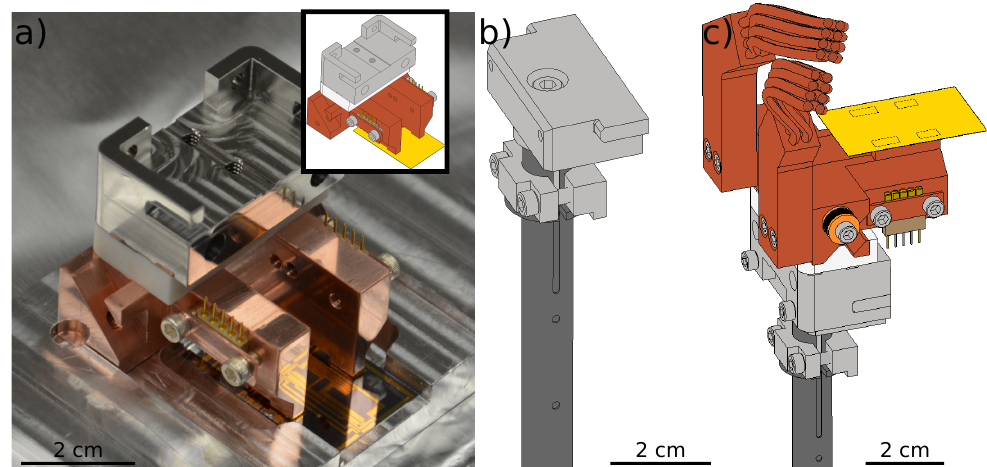
Figure 2: The sample mount. (a) The mount is shown resting upside down on an aluminum support scaffold outside vacuum. Inset: schematic of the sample mount viewed from a similar angle. (b) Diagram of the sample support tube in the vacuum chamber with sample removed. The sample mount slides onto the top of the block (shown in light gray) situated at the end of the support tube. It is secured in place by tabs at each side. (c) Diagram of the sample mount as it would appear within the vacuum chamber. Copper cooling braids attach to the sample mount with